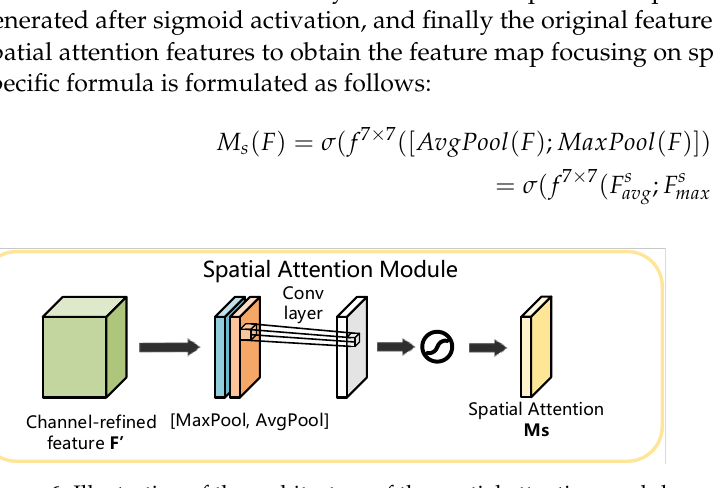
Figure 6. Illustration of the architecture of the spatial attention